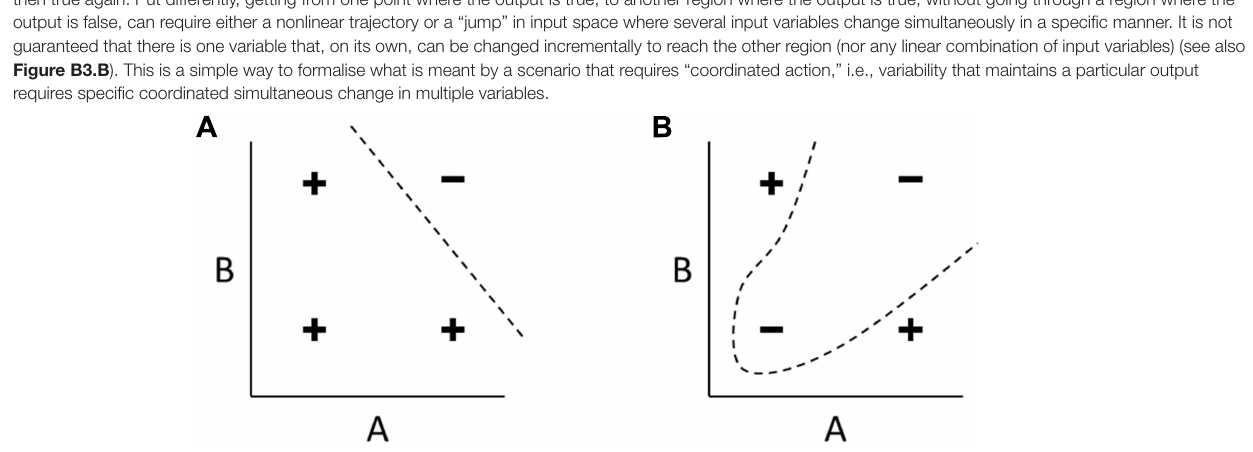
FIGURE B1 | Linearly separable and non-linearly separable functions. (A) A linearly separable function of two inputs A and B. The four combinations of high and low values are classified as either positive or negative. In any linearly separable function, like this example representing NAND(A,B), the positive and negative examples can be separated with a linear decision boundary (another example is shown in Figure B3.B ). (B) In any non-linearly separable function, like this example representing XOR(A,B), no such linear decision boundary can be drawn, and separating the two classes requires a non-linear